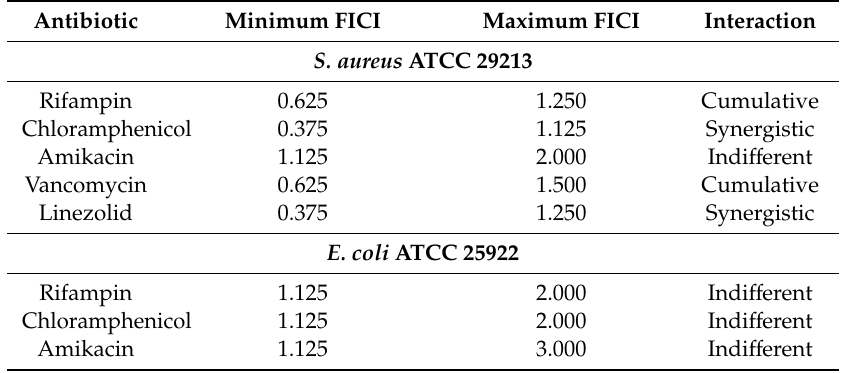
Table 2. Fractional Inhibitory Concentration Index (FICI) of WH and antibiotics. FICI was determined, where the MIC of the antibiotic in combination divided by the MIC of antibiotic alone + MIC of WH in combination divided by the MIC of WH alone was calculated. FICI ≤ 0.5 indicates synergism between compounds, > 0.5 to < 1.0 as cumulative interaction, > 1.0 to < 4.0 as indi ff